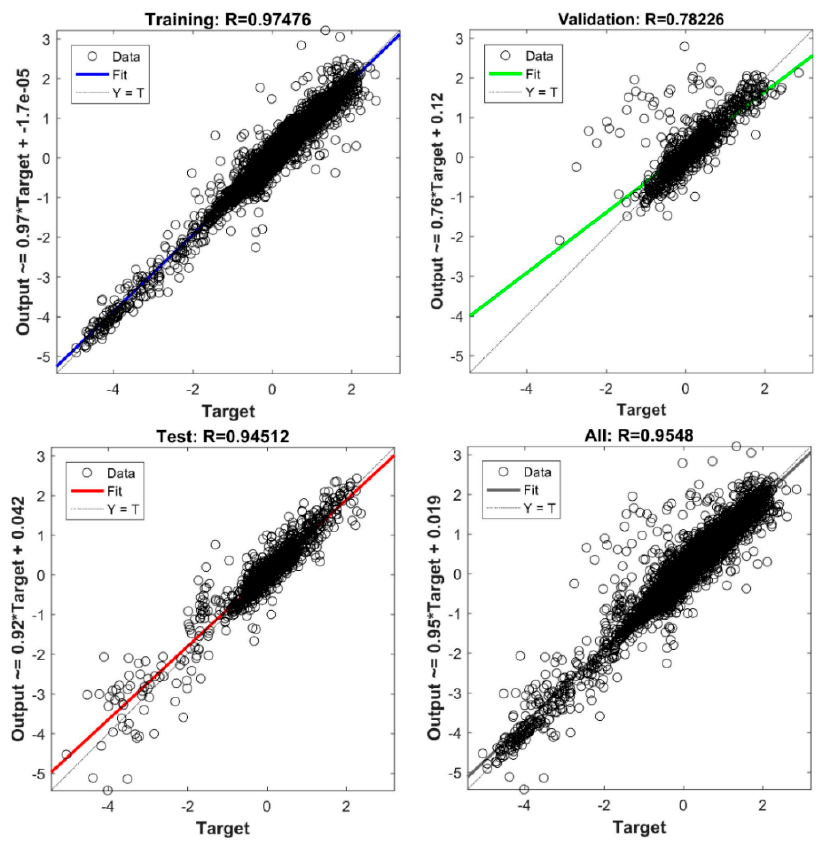
Figure 4. The correlation of target and output value.